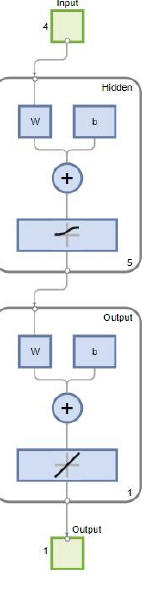
Figure 5. Feedforward neural network model.